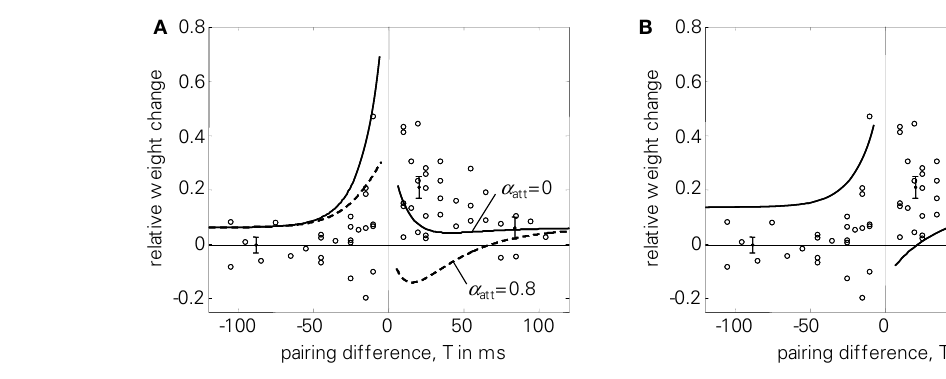
(dashed) and without (solid) postsynaptic attenuation, Wang parameter set (see Table 4 ); E = 5.6 without attenuation; (B) standard STDP rule with same parameter set, E = 17.8.